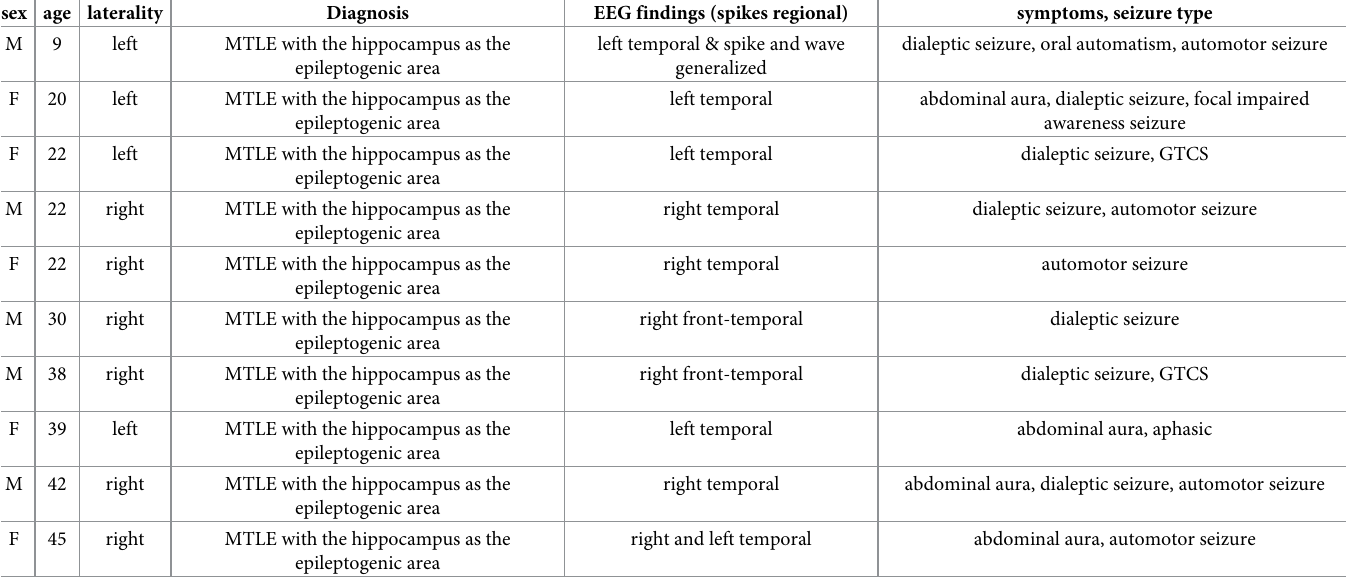
Table 2. Validation data set.